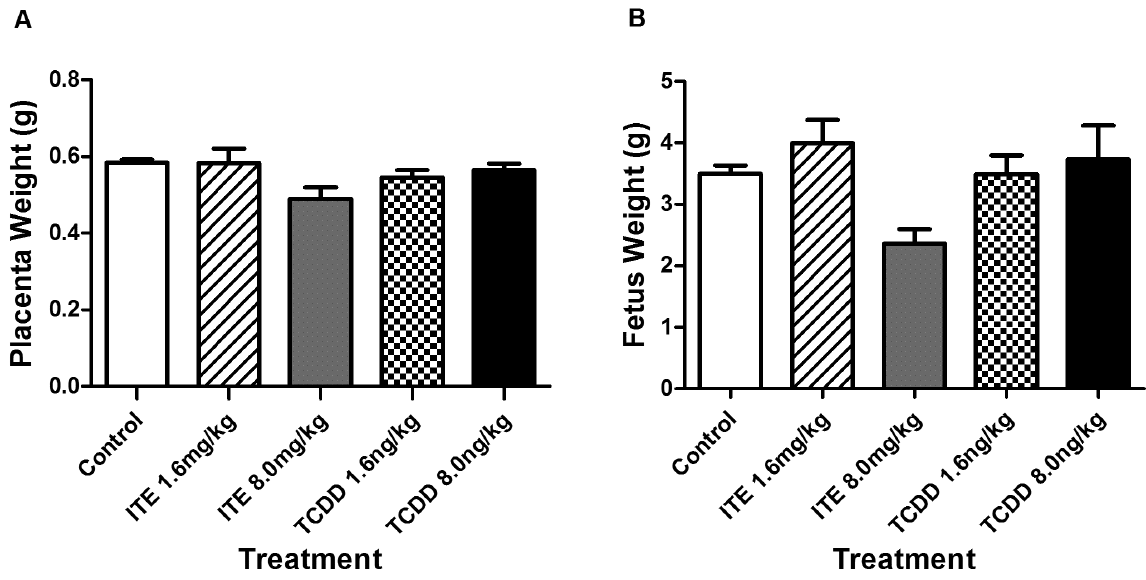
Figure 1. Effects of ITE and TCDD on placental (A) and fetual weights (B). The pregnant rats on GD15 were given ITE, TCDD or the vehicle- control (corn oil). Animals were euthanized on GD20. Placental and fetual weights were recorded. No significant difference was observed among the vehicle-control, ITE and TCDD treatment groups ( p . 0.05). Data are expressed as means 6 S.E.M. (at least five placentas or fetus were counted in each group).